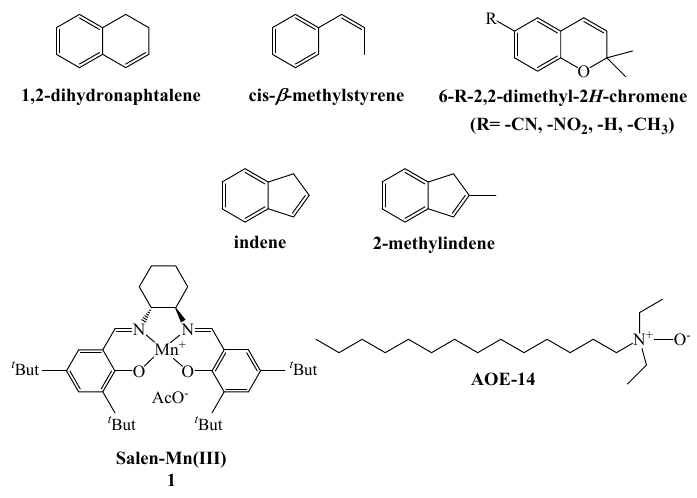
Figure 1. Alkenes, Mn(III) catalyst and surfactant with relative acronyms used in this work.